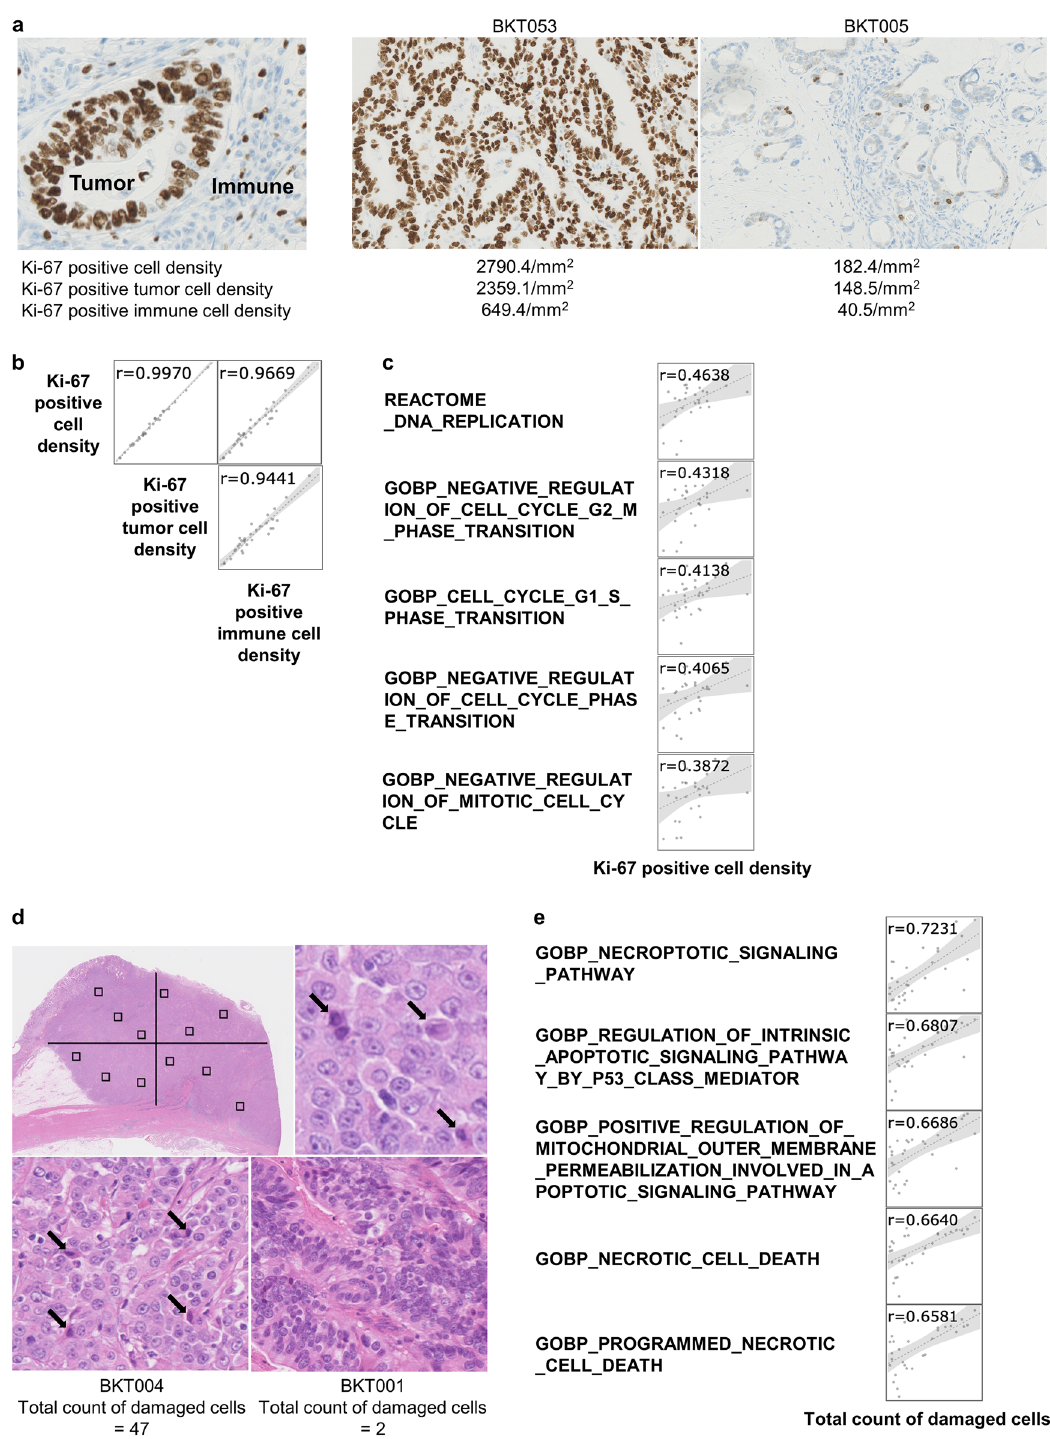
Figure 3. Cell proliferation and cell death in the tumor. ( a ) The slides were stained with anti-Ki-67 and the number of Ki-67 + cells was counted in the whole tumor area. The Ki-67 + cell densities were calculated as the number of Ki-67 + cells divided by tumor tissue area (mm 2 ). Cells with a nucleus size ≥ 30 μm 2 were considered to be cancer cells, and those with < 30 μm 2 were regarded as immune cells. Slides with the most (BKT053) and the least (BKT005) Ki-67 + cells are shown. ( b ) Correlations between scores for the indicated Ki-67 + cell densities were examined. The Pearson’s correlation coefficients (r) between the two are indicated at the top of the panels. ( c ) The vertical axis shows the indicated ssGSEA scores. The horizontal axis shows the Ki-67 + cell densities. ( d ) In H&E slides, tumor cells with elevated cytoplasmic acidity, nuclear fragmentation, or enrichment were defined as damaged cells (arrow). The tumor tissue was equally divided into 4 parts, and 3 areas of 25 mm 2 each were randomly selected in each fraction. The number of damaged cells was counted in each area and the total number of damaged cells was obtained as the sum of the numbers from 12 areas. The tissues with the most (BKT004) and the least (BKT001) damaged cells are indicated. ( e ) The vertical axis shows the indicated ssGSEA scores. The horizontal axis shows the number of damaged cells. Correlations between the ssGSEA score for cell death and the total number of damaged cells in H&E slides were examined. The Pearson’s correlation efficient (r) is shown in the upper part of each scatter